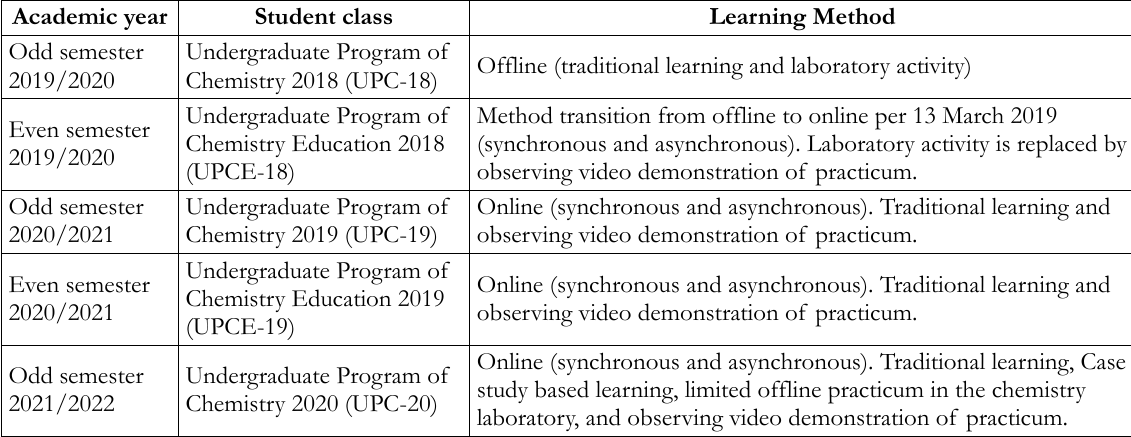
Table 2. Method transition on chemical thermodynamics course during the COVID-19 pandemic The learning method transition (offline-online) influenced students’ final score after programed chemical thermodynamics course described in the Figure